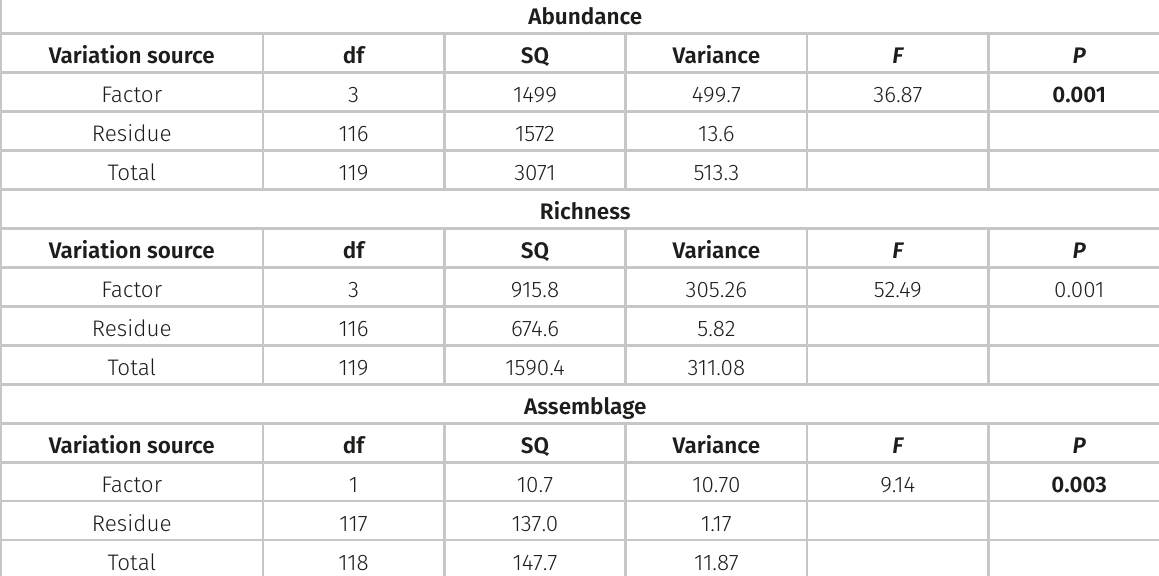
Table IV. Analysis results of variance of environmental variables between sample periods. SQ = Quadratic sum, df = Degree of freedom, F = F statistic value , P = p value. Values in bold, significant at ≤